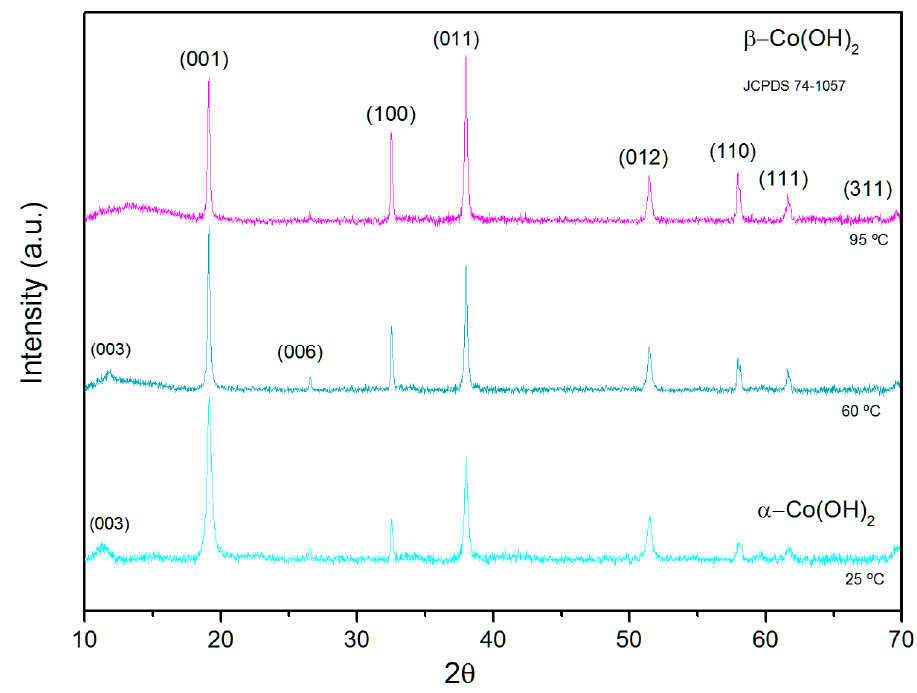
Figure 3. XRD patterns of the as-prepared Co(OH) 2 films.